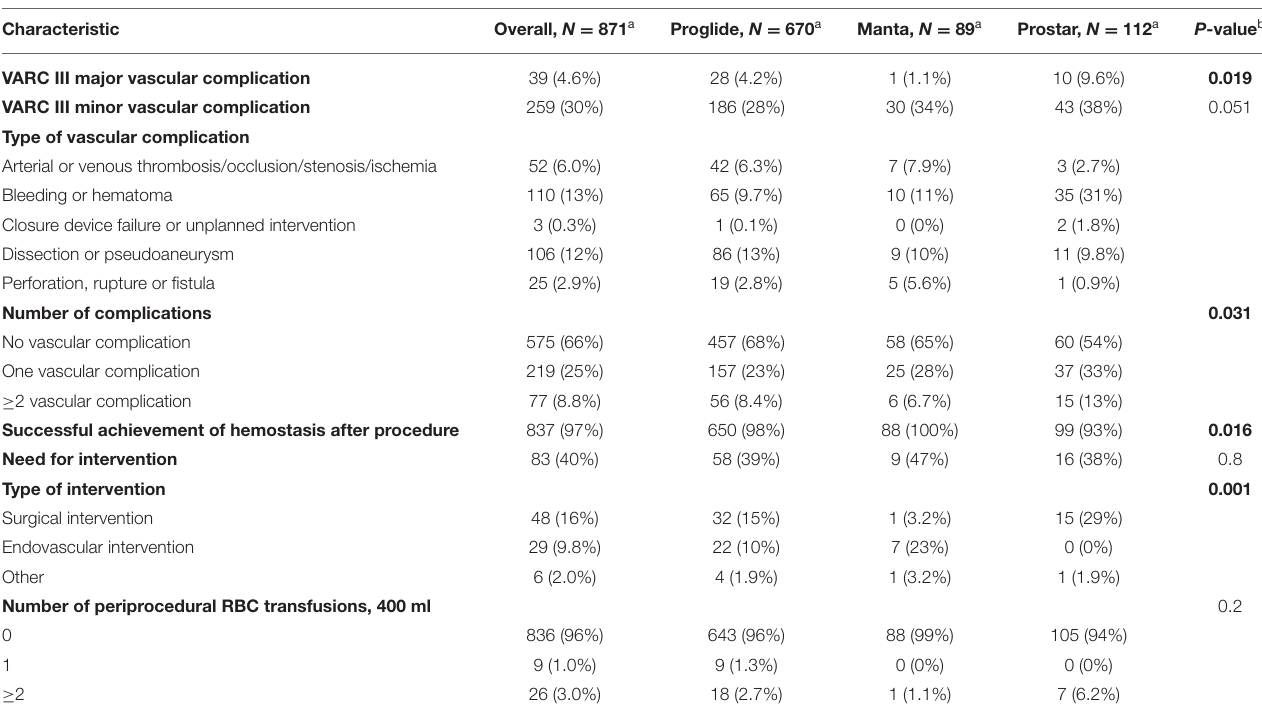
TABLE 3 | Vascular complications according to the main vascular closure device used.